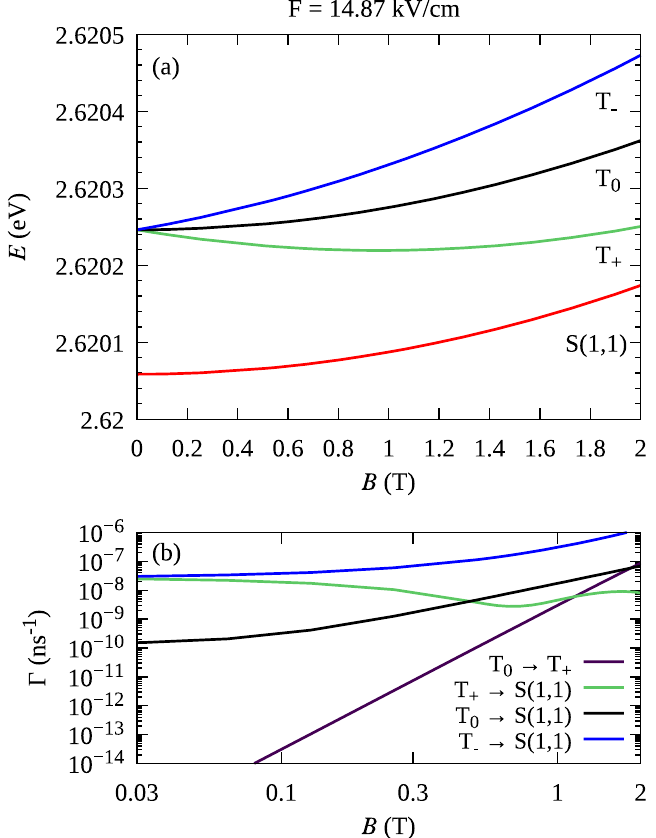
0 K ( b ) as a function of axial =